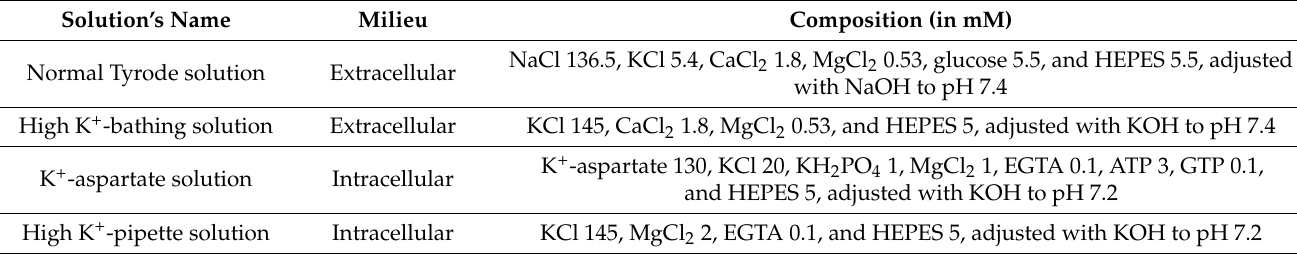
Table 1. The composition of extracellular and intracellular solutions used in this